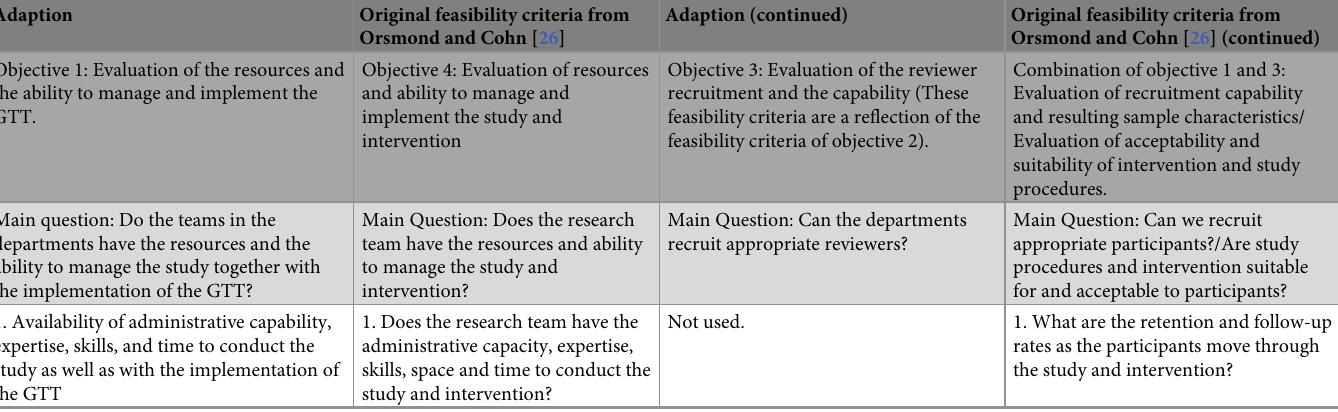
Table 2. Adapted and original feasibility criteria from the study and Orsmond and Cohn [26].